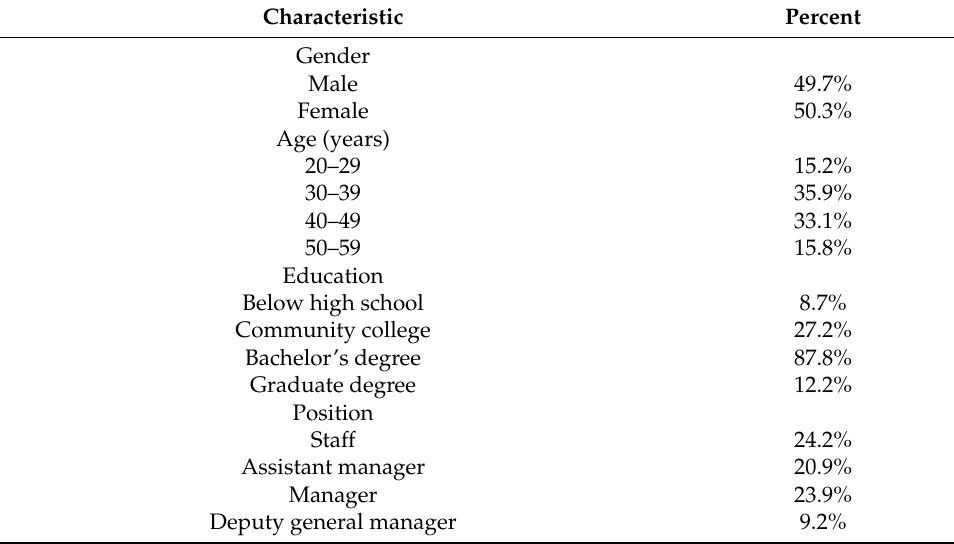
Table 1. Descriptive Features of the Sample.